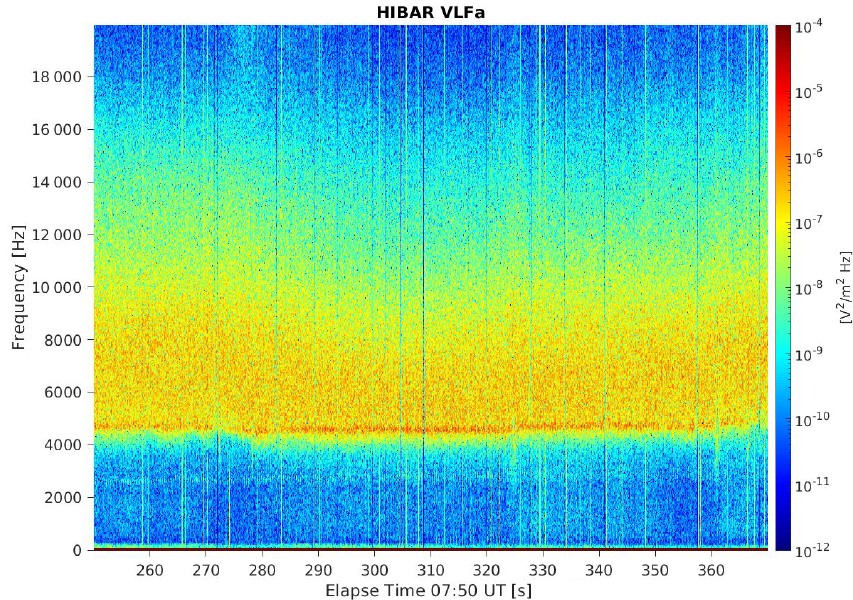
Figure 3. Frequency–power spectrogram of the HIBAR VLF wave data from 0–20kHz and 07:54:10–07:56:10UT (250–370s), showing the broadband diffuse whistler-mode waves and a slightly enhanced power band at ∼ 5kHz corresponding to probable LH